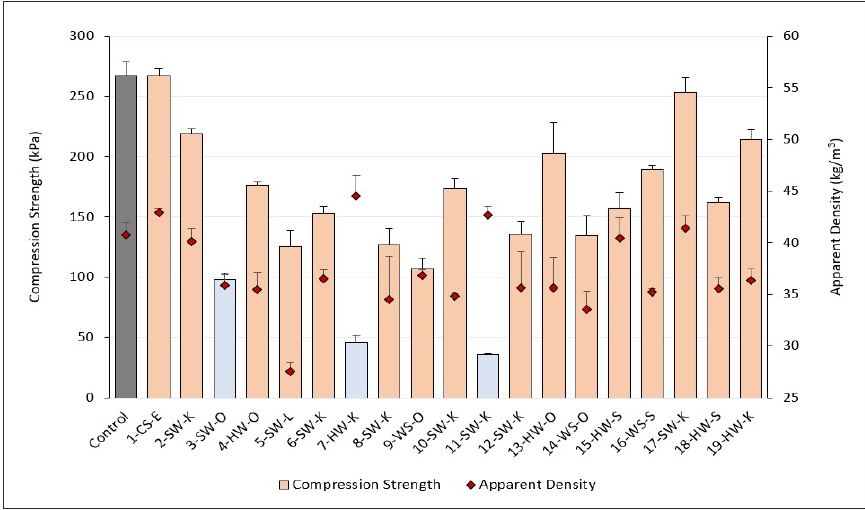
Figure 4. Compression strength and apparent density of foams. Blue bars failed the compression test (<104 kPa). Note that the axis does not start at 0 for apparent density.